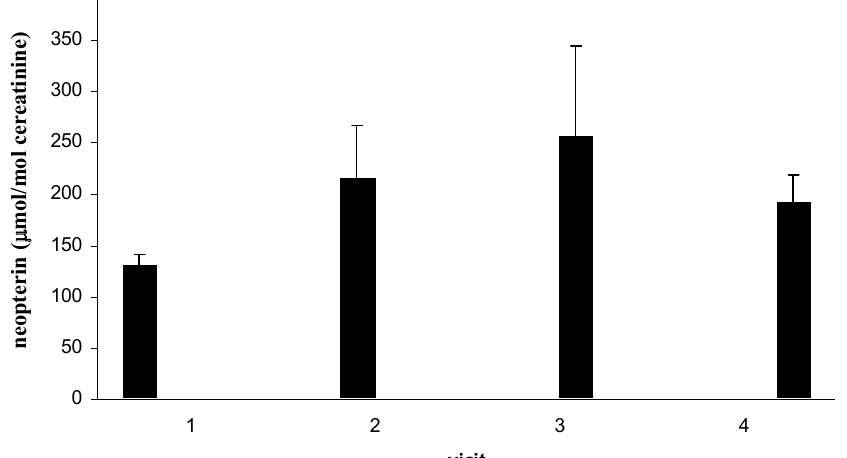
Figure 1. Urinary neopterin during the course of therapy. Shown are the means of urinary neopterin before and during the therapy. Error bars indicate the standard error of the mean. Compared to pretreatment concentrations, urinary neopterin was significantly (Wilcoxon signed rank test, p < 0.05) increased throughout the course of the-